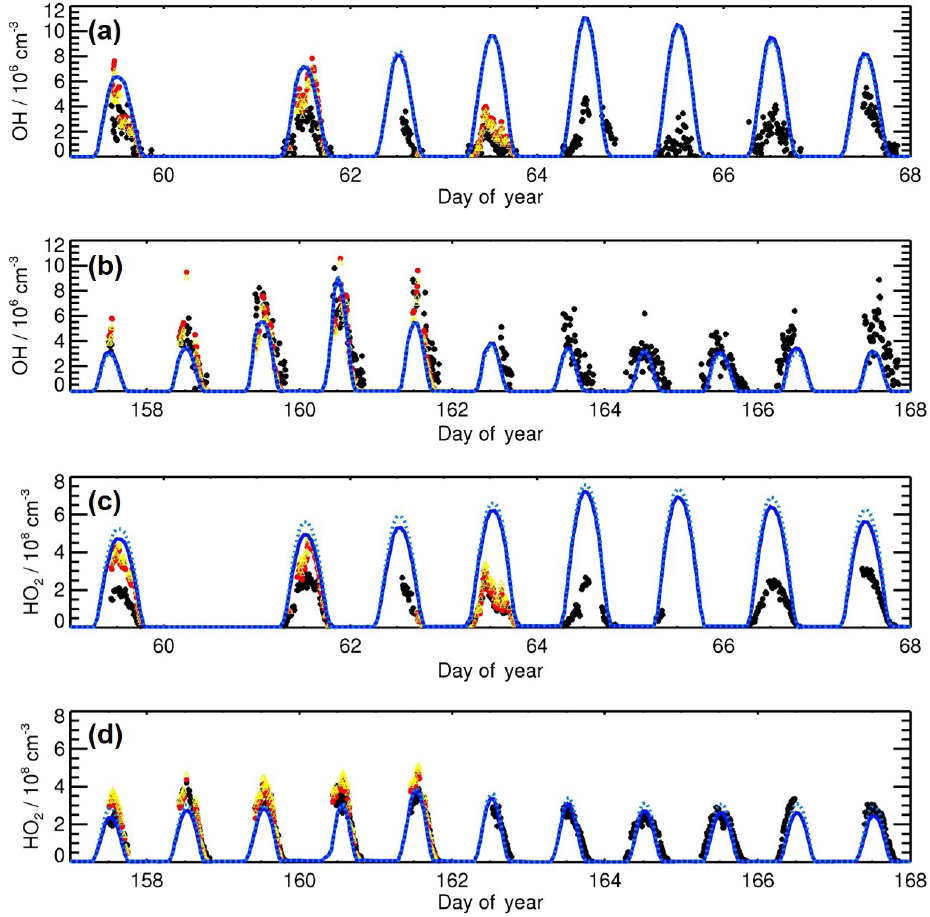
Figure 1. Observed and modelled concentrations of (a) OH during SOS1 (February–March 2009, days 58–68); (b) OH during SOS2 (May– June 2009, days 157–168); (c) HO 2 during SOS1; (d) HO 2 during SOS2. Observed data are shown in black; box model concentrations with halogen chemistry are shown by filled red circles; box model concentrations without halogen chemistry are shown by open yellow triangles; global model concentrations with halogen chemistry are shown by solid dark blue lines; global model concentrations without halogen chemistry are shown by broken blue